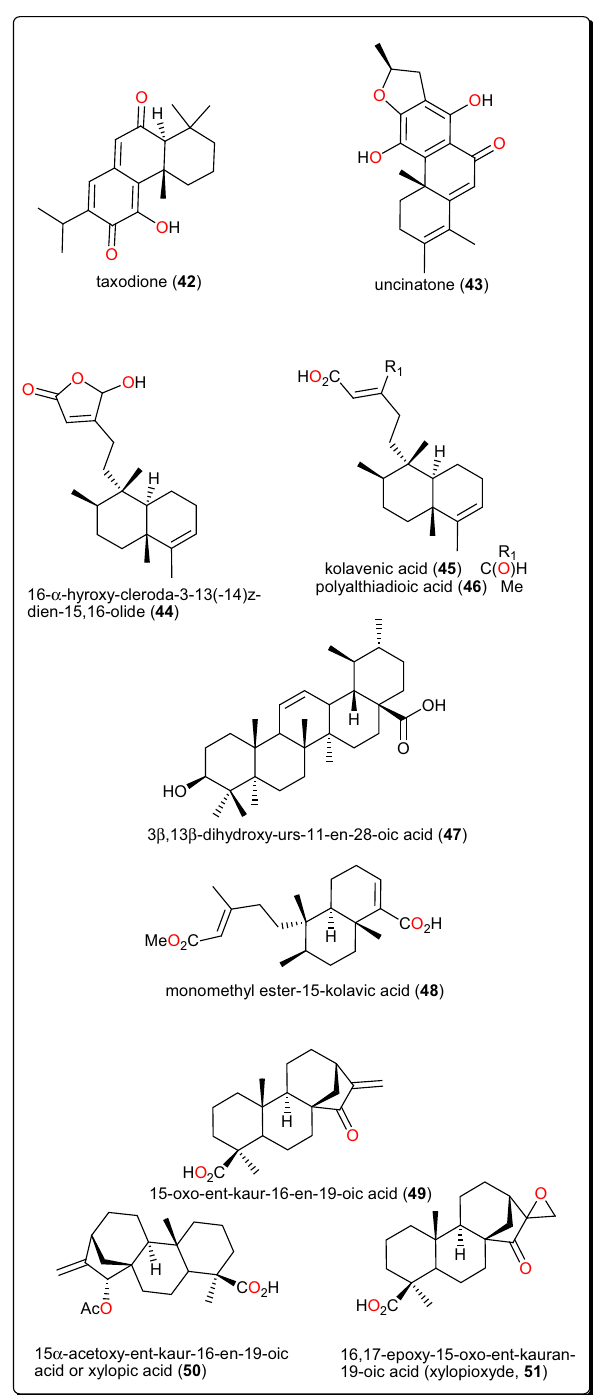
Fig. 8 Diterpenoids and a triterpenoid with selective inhibitory activity against T. brucei